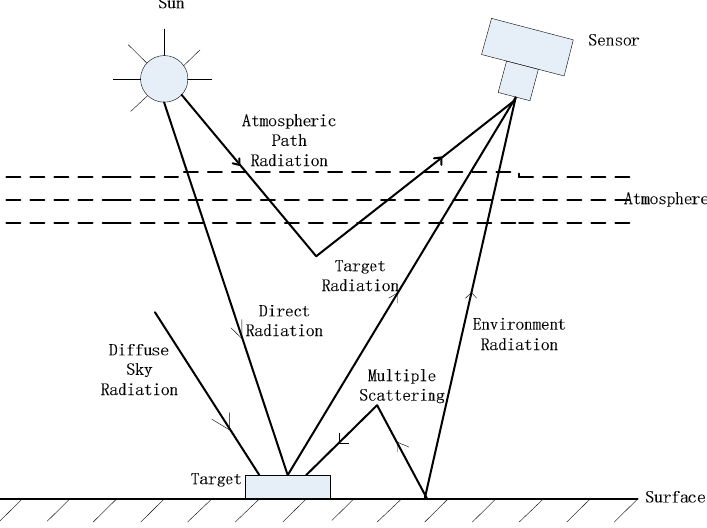
Figure 1. Schematic diagram of sun, target and sensor’s reciprocity.